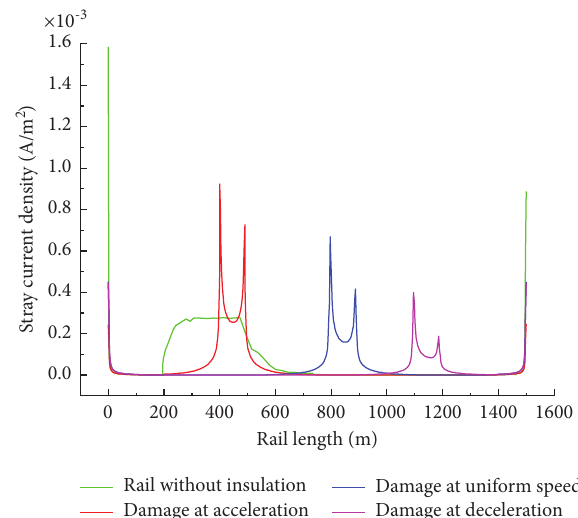
Figure 9: Total corrosion current density of rail under different